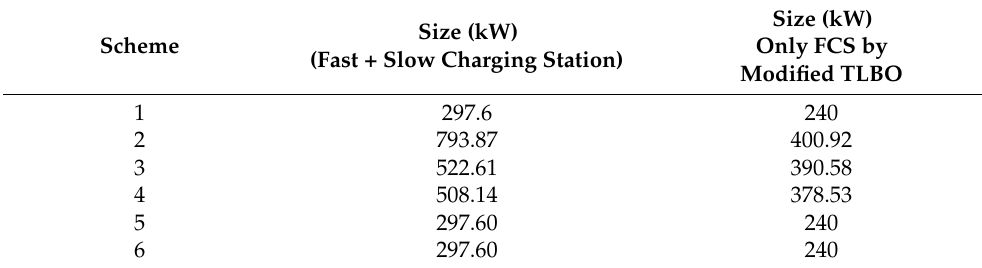
Table 9. Optimal sizing of CSs based on VRP index for 33-bus system.